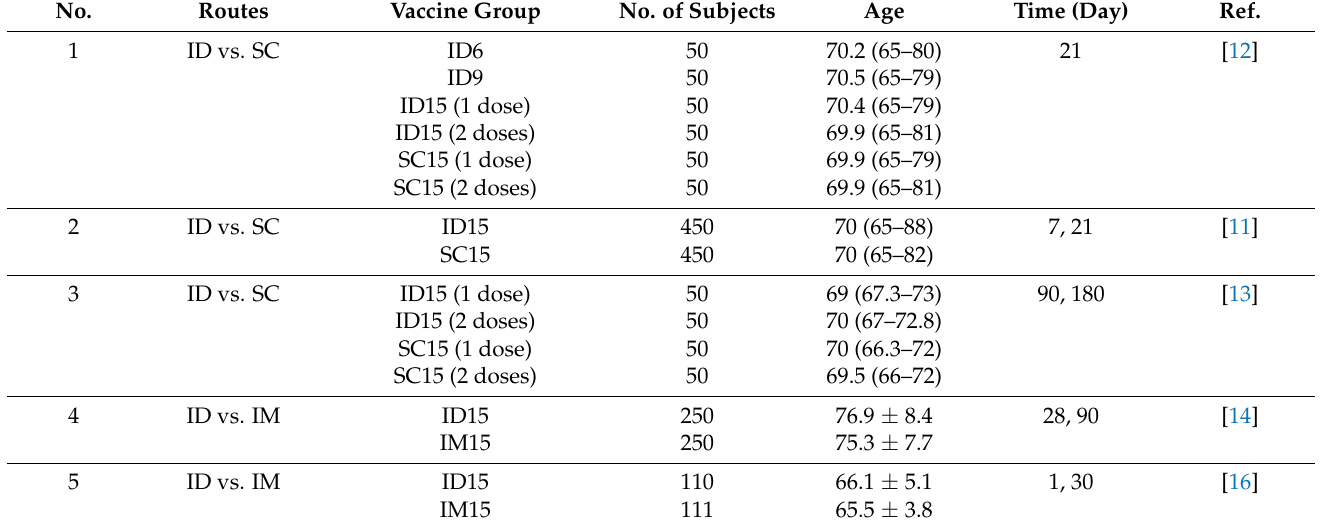
Table 1. Demographic characteristics of the study subjects. In the “Vaccine group” column, study subjects were vaccinated via either intradermal (ID), subcutaneous (SC), or intramuscular (IM) routes, with varying amounts of hemagglutinin, including 4.5, 6, 9, 15, 21, 45, and 60 µ g of hemagglutinin for each vaccine viral strain (indicated as numbers after ID, SC, or IM). In the “Age” column, age is expressed either by median (range) or mean ± standard deviation (SD). In two studies [21,22], age and age distribution were not specified, although all study subjects in these two studies were ≥ 65 years. The “Time” column indicates the time of post-vaccination to assess the immune responses induced by influenza